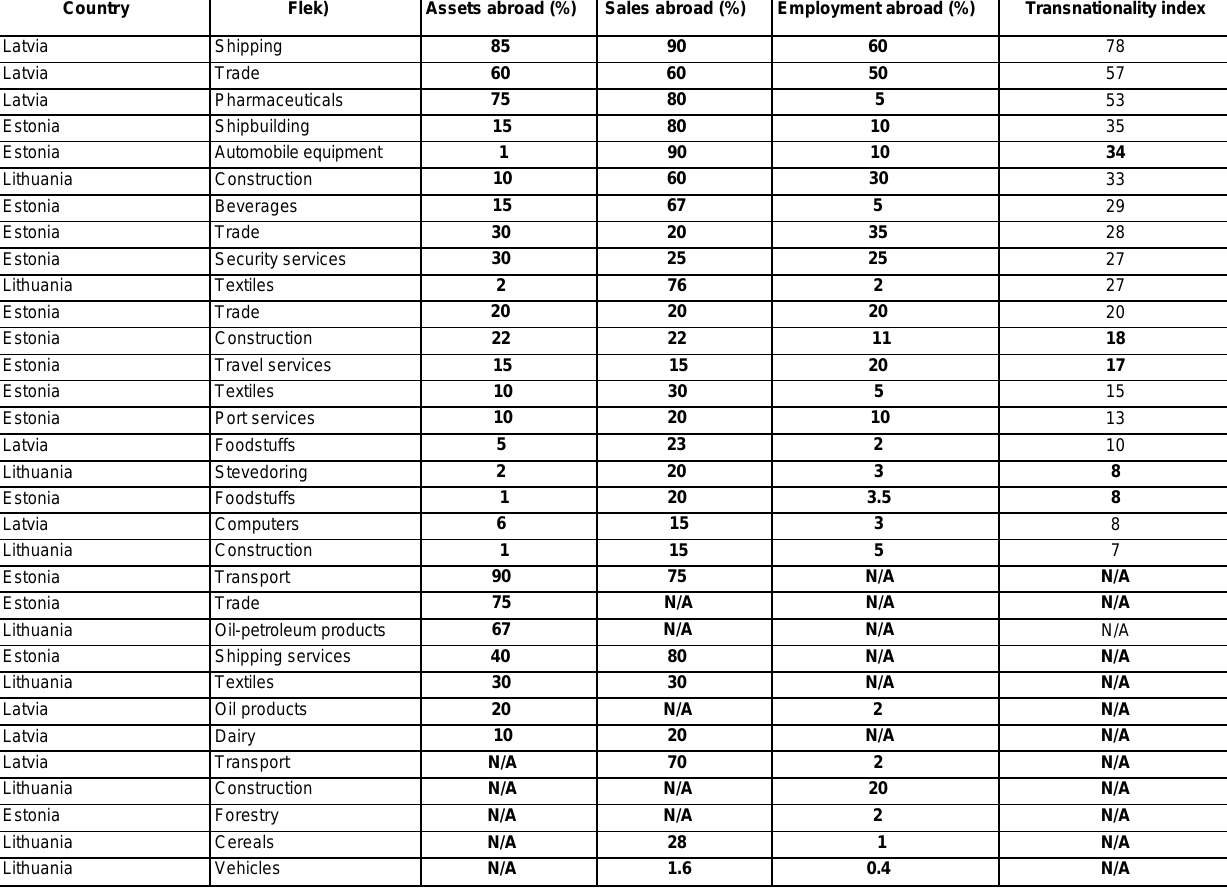
Table 12. The Transnationality Analysis of the Studied Baltic